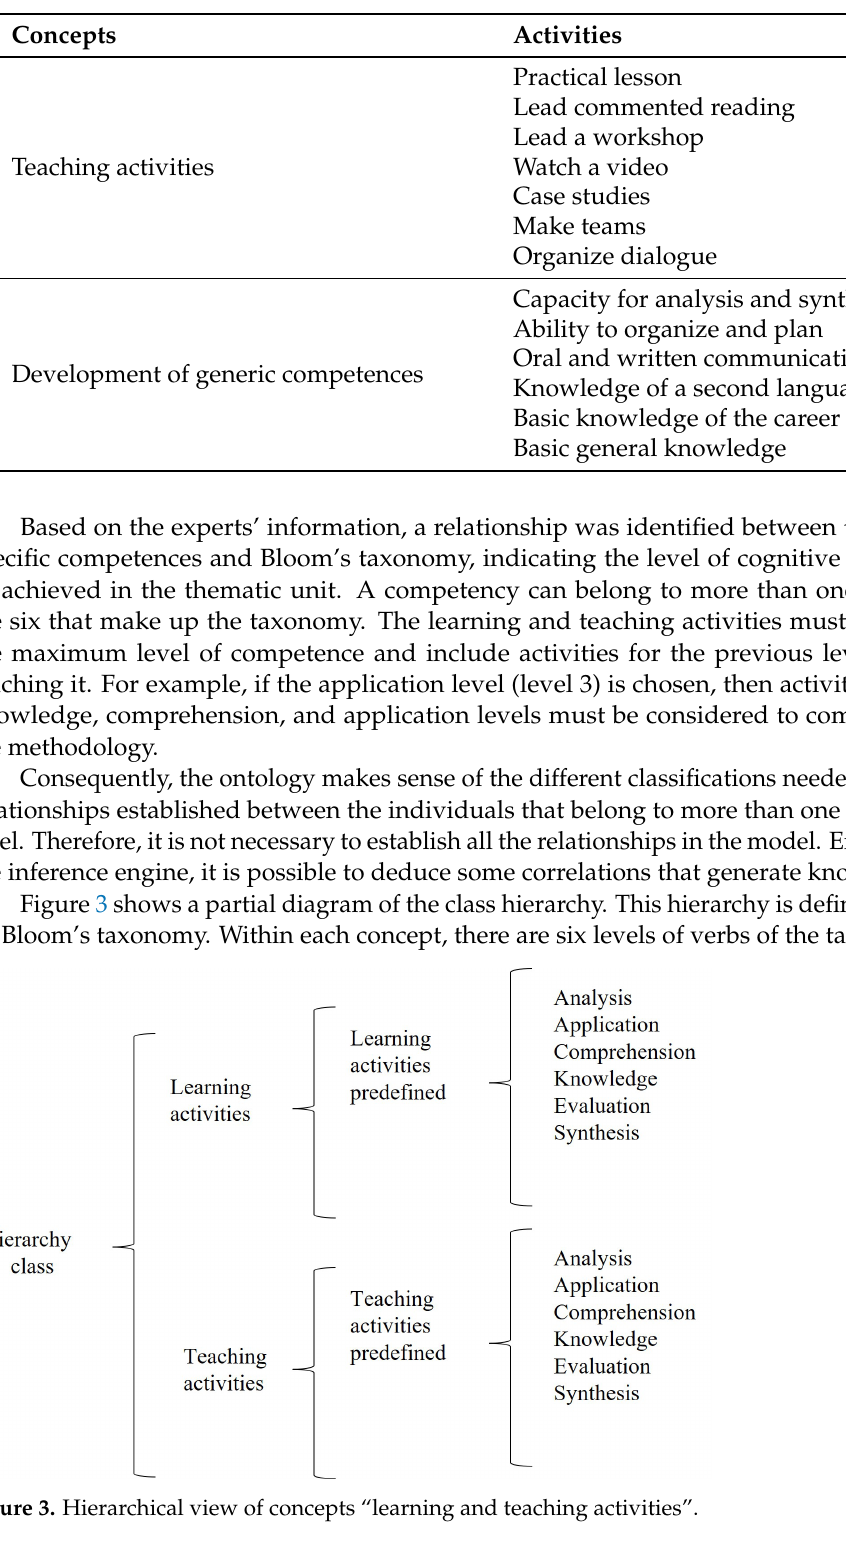
Table 2. Short view of glossary of two concepts.